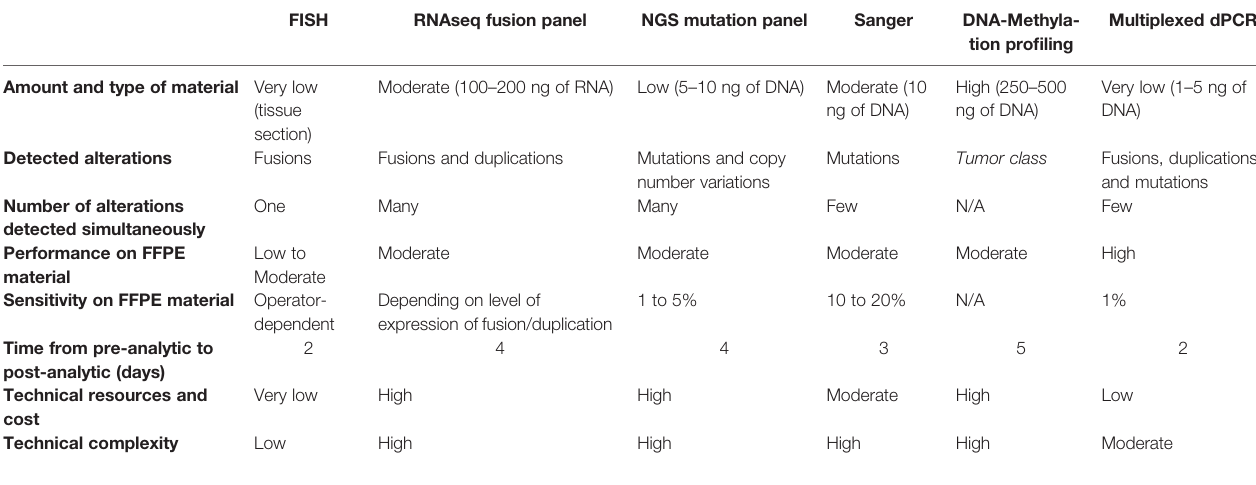
TABLE 2 | Comparison between the techniques commonly used for the detection of targeted